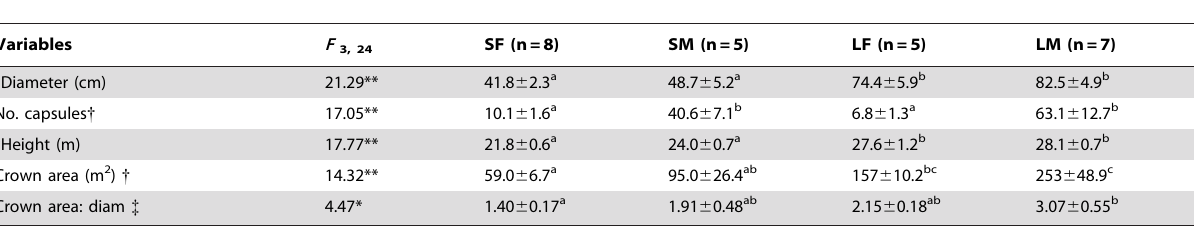
Table 3. Tree characteristics of mahogany ( Swietenia macrophylla ) trees grouped into four size-fecundity classes at the Marajoara forest in Para´,